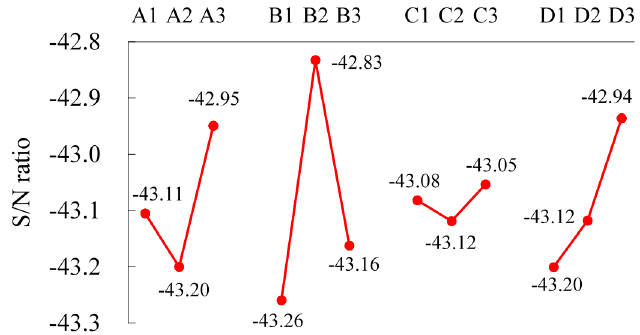
Figure 3. The factor response diagram for hardness.